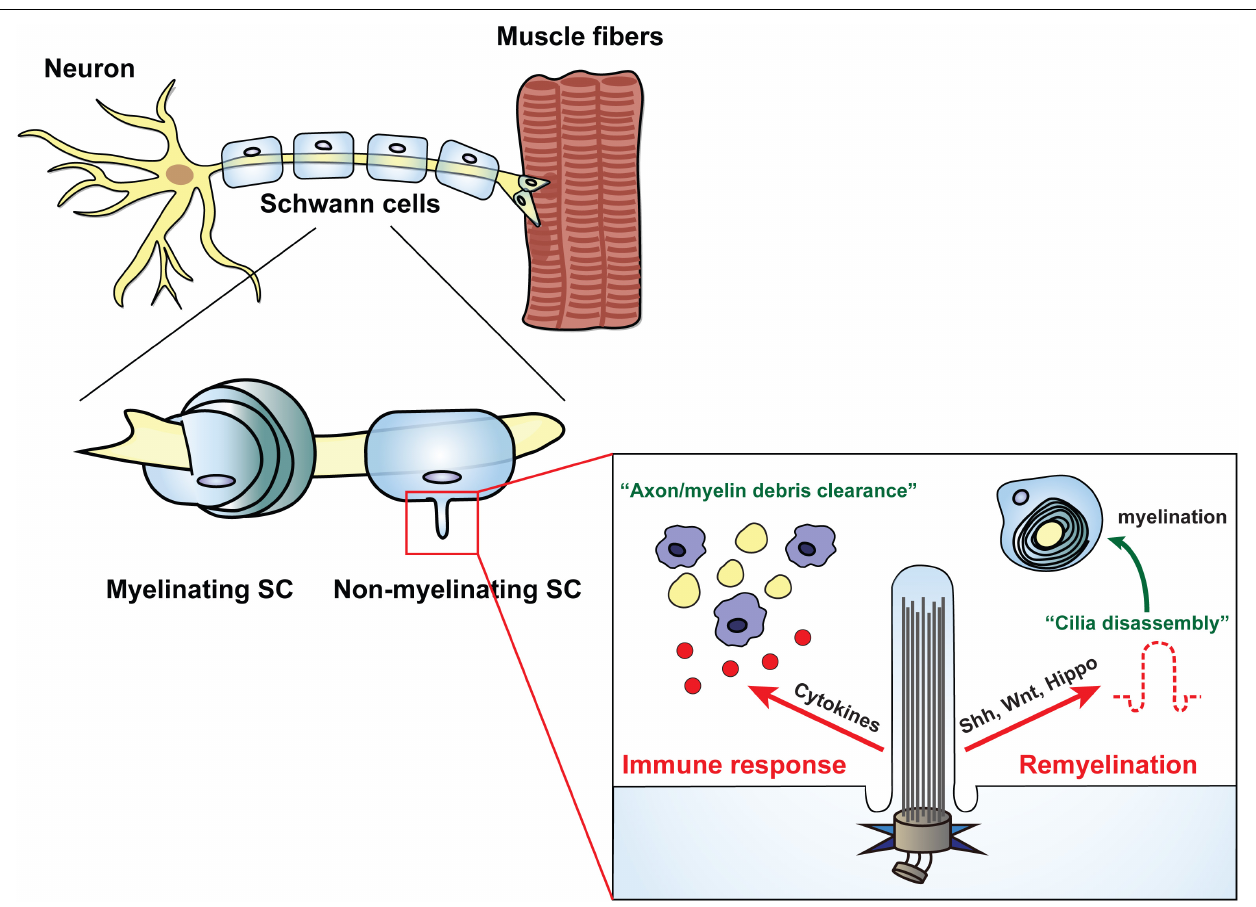
FIGURE 3 | Schwann cells regulate various cellular processes through the primary cilia. Primary cilia generated in non-myelinating Schwann cells are involved in cellular events through dynamic biogenesis of assembly and disassembly. In the immune response state, the primary cilia of Schwann cells induce clearance of axon debris by macrophages through activation of inflammatory cytokines. In PNS injury, Schwann cells play a role in axonal regeneration by inducing remyelination through the disassembly of primary cilia, which is dependent on several signal transductions such as Shh, Wnt, and